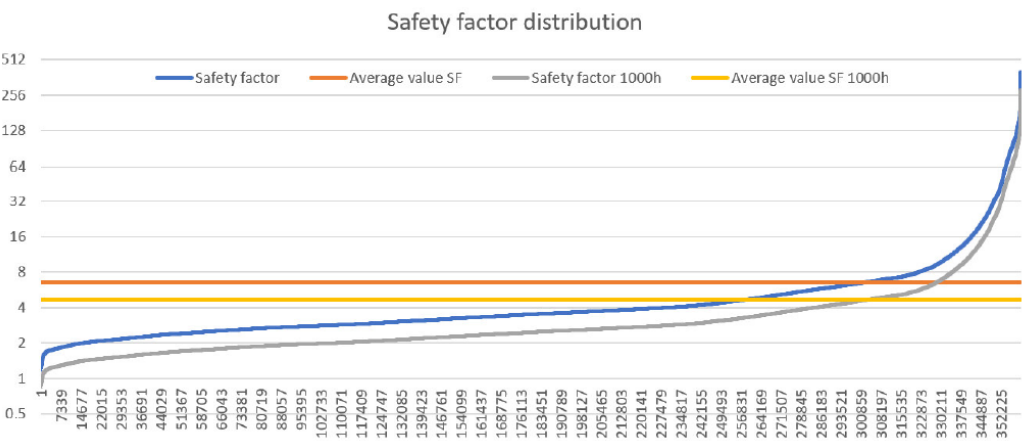
Appl. Sci. 2020 , 10 , x FOR PEER REVIEW Figure 46. Safety factor (SF) distribution calculated at each mesh node (log 2 scale on the vertical axis).